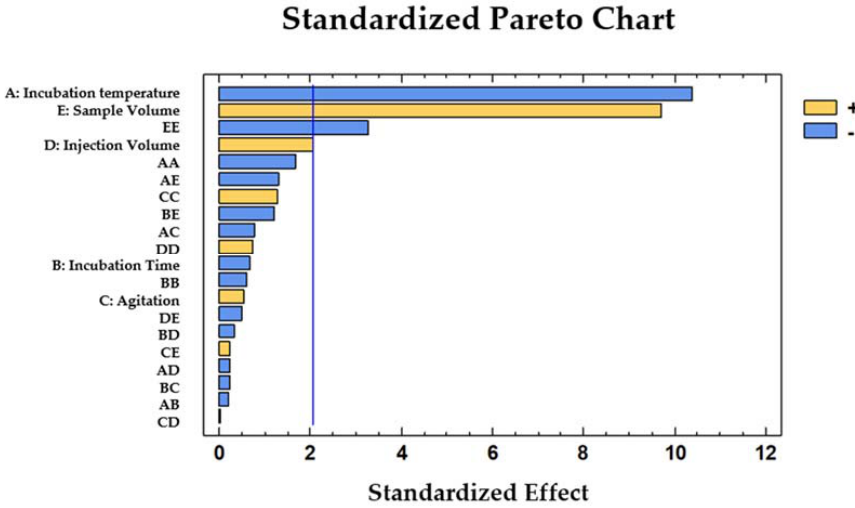
Figure 2. Standardized Pareto chart representing the five variables optimized for the discrimination between gasoline, diesel, lubricant and kerosene in water.